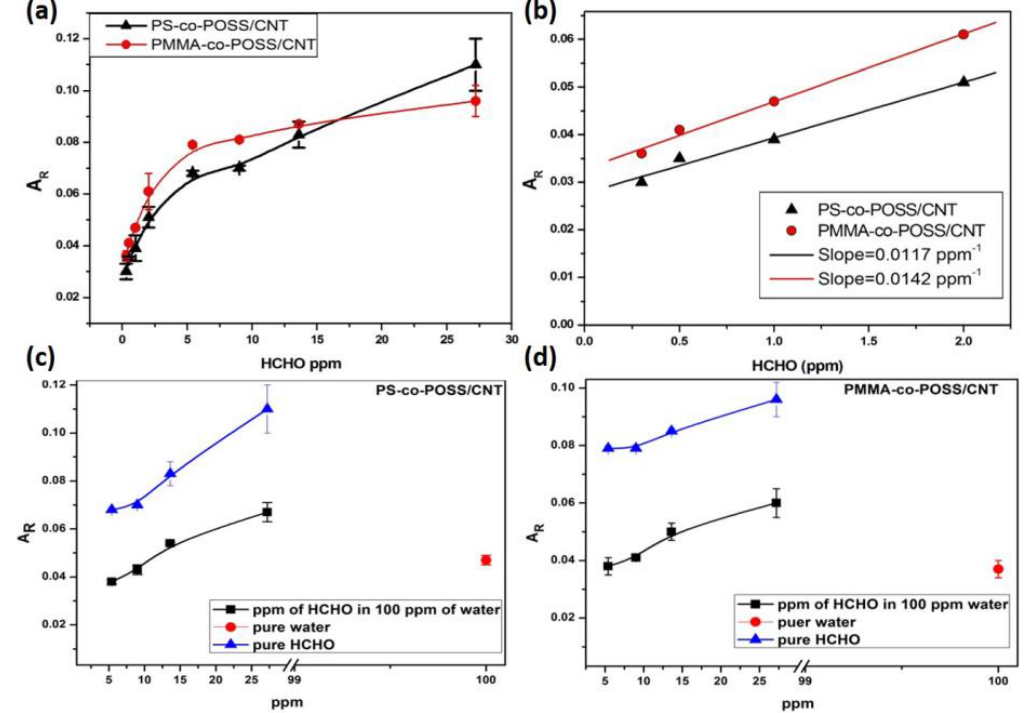
Figure 5. ( a ) PS-co-POSS/CNT and PMMA-co-POSS/CNT sensors response towards CH 2 O; and ( b ) sensitivity of both sensors towards CH 2 O, and CH 2 O sensing in presence of 100 ppm of water by ( c ) PS-co-POSS/CNT and ( d ) PMMA-co-POSS/CNT sensors respectively.